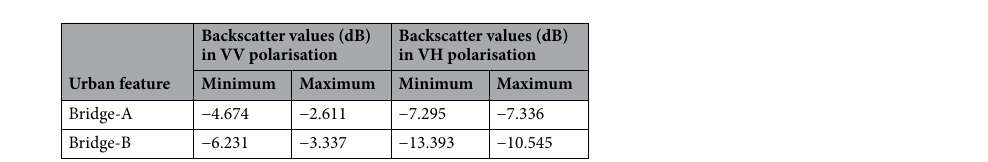
Table 14. Summary of variations in backscatter values for